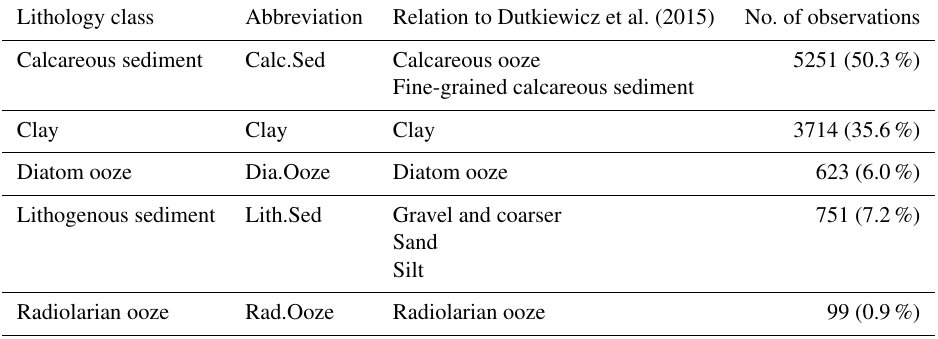
Table 2. Seafloor lithology classes used in this study, their abbreviations, their relationships to classes in Dutkiewicz et al. (2015) and the number and percentage of samples. Not included are ash and volcanic sand or gravel, mixed calcareous–siliceous ooze, siliceous mud, sponge spicules, and shells and coral fragments of the original